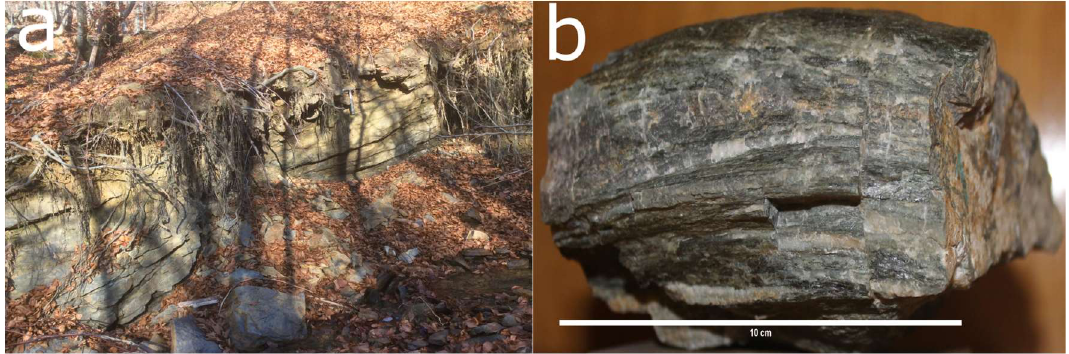
Figure 6. ( a ) Outcrop with the greenschists in the Medvednica mountains; ( b ) hand sample of the greenschist from the Medvednica mountains. greenschist from the Medvednica